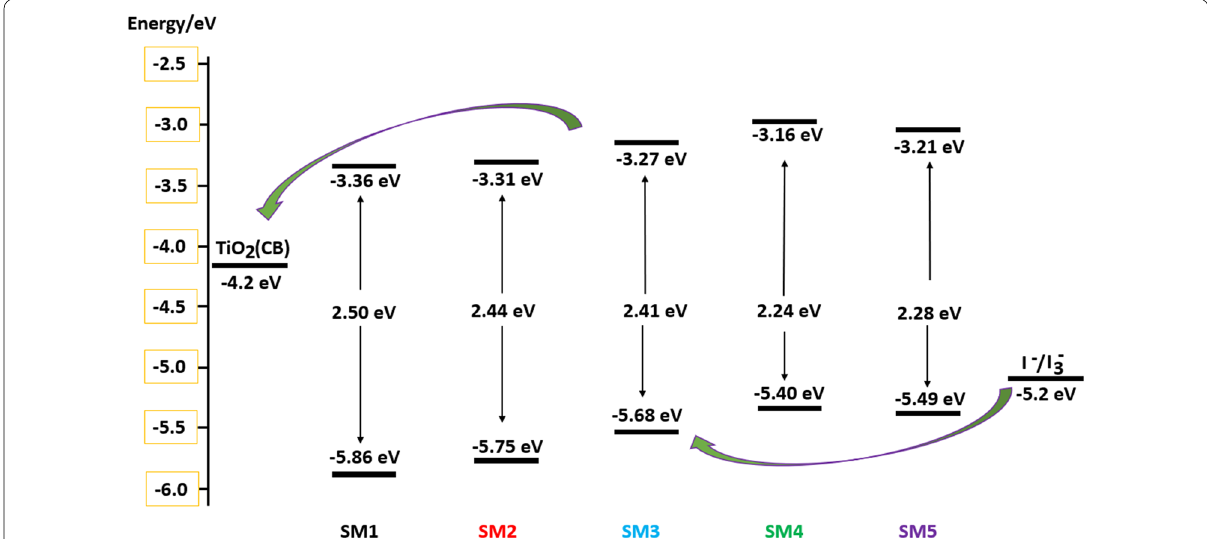
Fig. 7 Energy level diagram of dyes